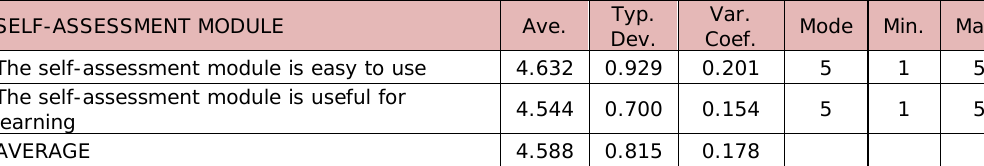
Table 4. “Assessment of Self-Assessment Module”.